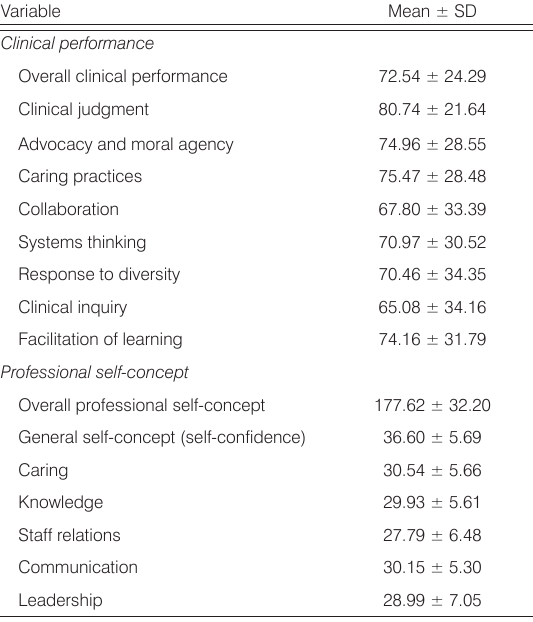
Table 2. The mean and SD of critical care nurses’ clinical performance, professional self-concept, and their subscales.